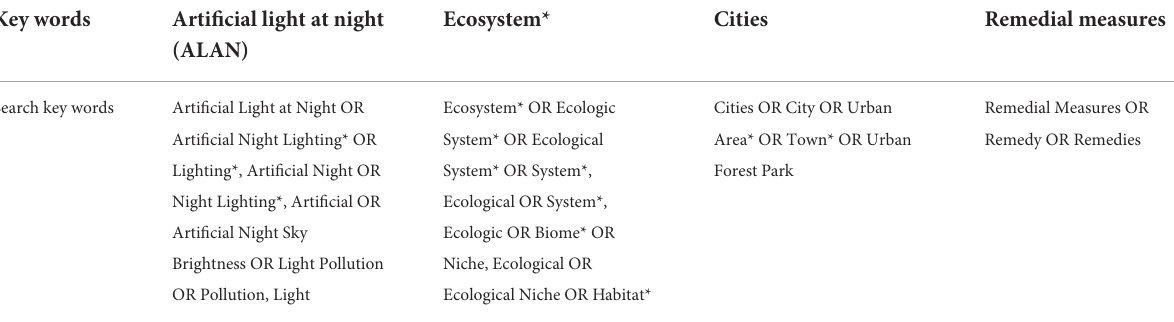
TABLE 1 The search terms used in the literature collection from the selected database.